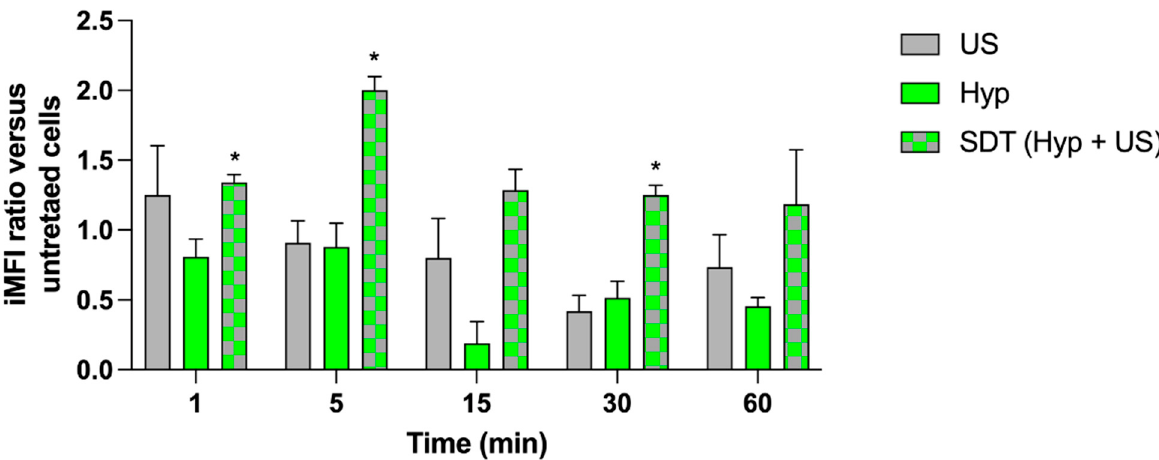
Figure 4 . ROS generation under sonodynamic exposure of Hyp. HT-29 cells were incubated for 24 h with 0.1 μ M Hyp and then exposed to US (1.5 W/cm 2 at 1.5 MHz, continuous wave mode for 5 min). Statistically significant difference versus untreated cells: * p ≤ 0.05 ( n = 3).